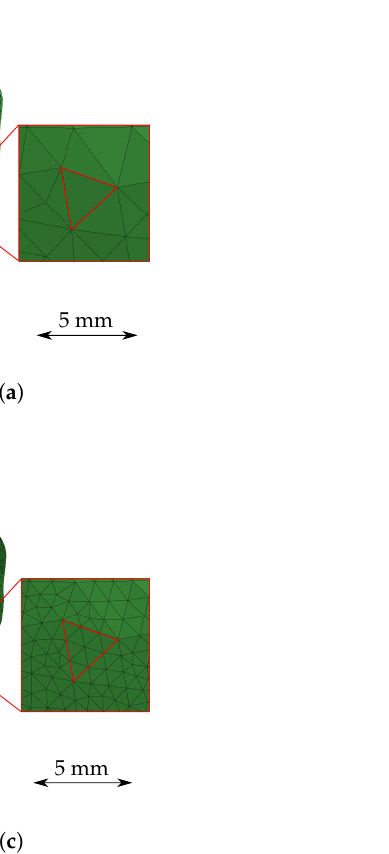
Figure 28. Mesh sensitivity study of numerically generated porosity specimen #31 ( a ) Average element size: 500 µ m ( b ) Average element size: 250 µ m ( c ) Average element size: 167 µ m ( d ) Average element size: 125 µ